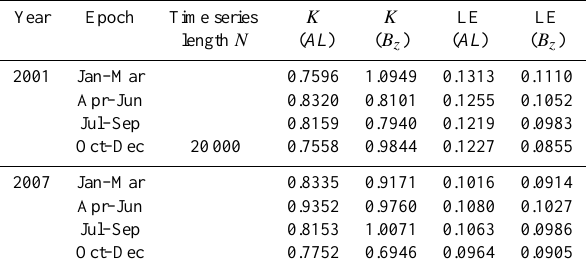
Table 1. The K values of the 0–1 test for chaos and the correspond- ing Lyapunov exponents, computed using the Hegger et al. (1999) algorithm, for the 3-month epochs of 2001 and